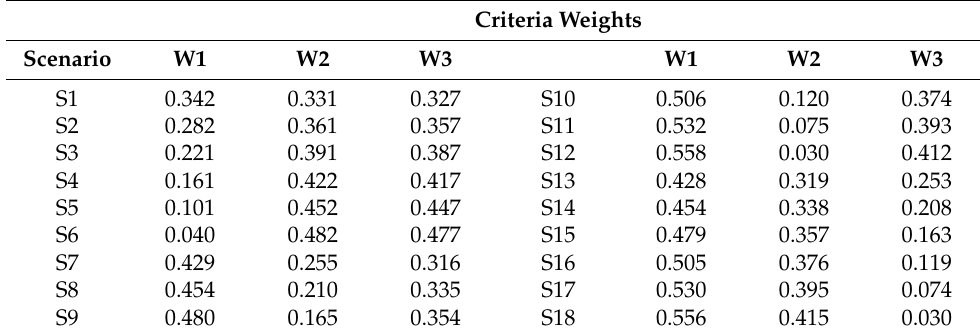
Table 14. New simulated criterion values through 18 scenarios.